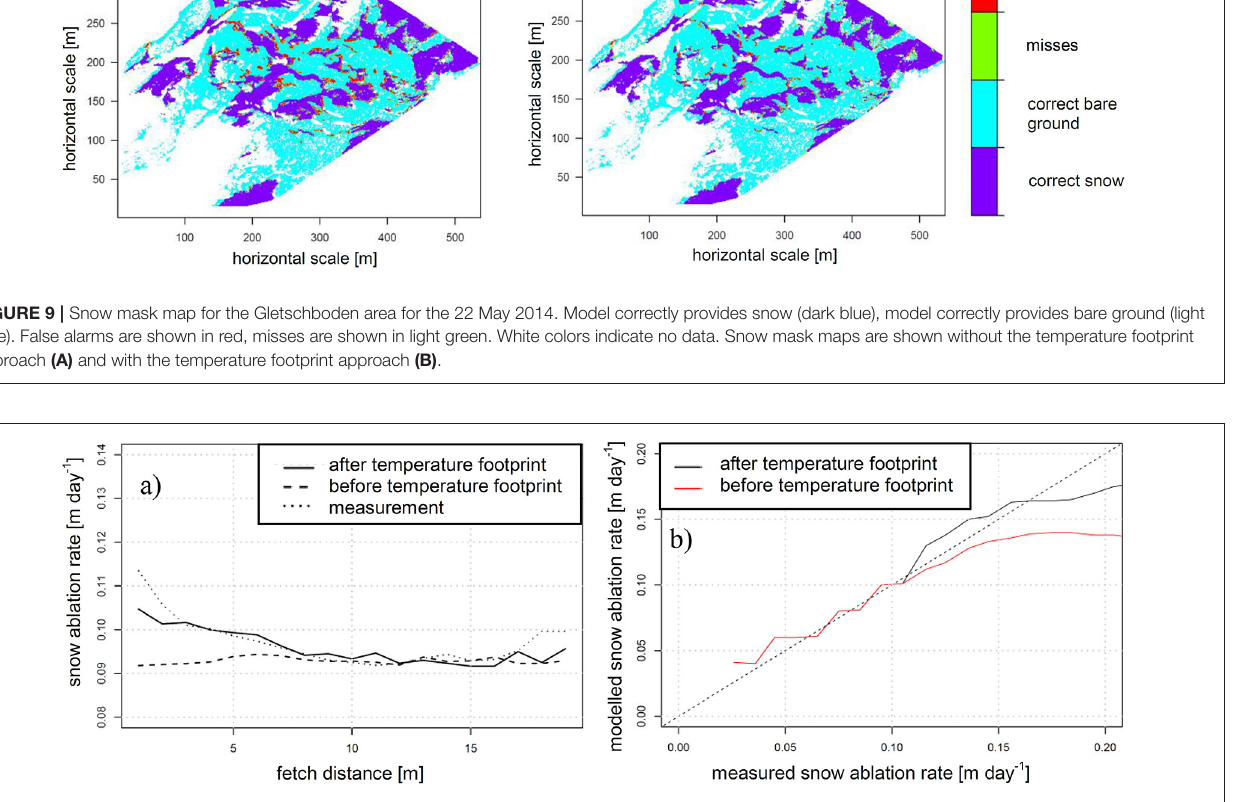
FIGURE 10 | Snow ablation rate for the 21 May 2014 [m day − 1 ] as a function of the fetch distance [m] (A) for the terrestrial laser scanning measurement and the model results with and without applying the temperature footprint approach. Snow ablation rate [m day − 1 ] for the model results (with and without applying the temperature footprint approach) (y-axis) as a function of the measured snow ablation (x-axis) (B)